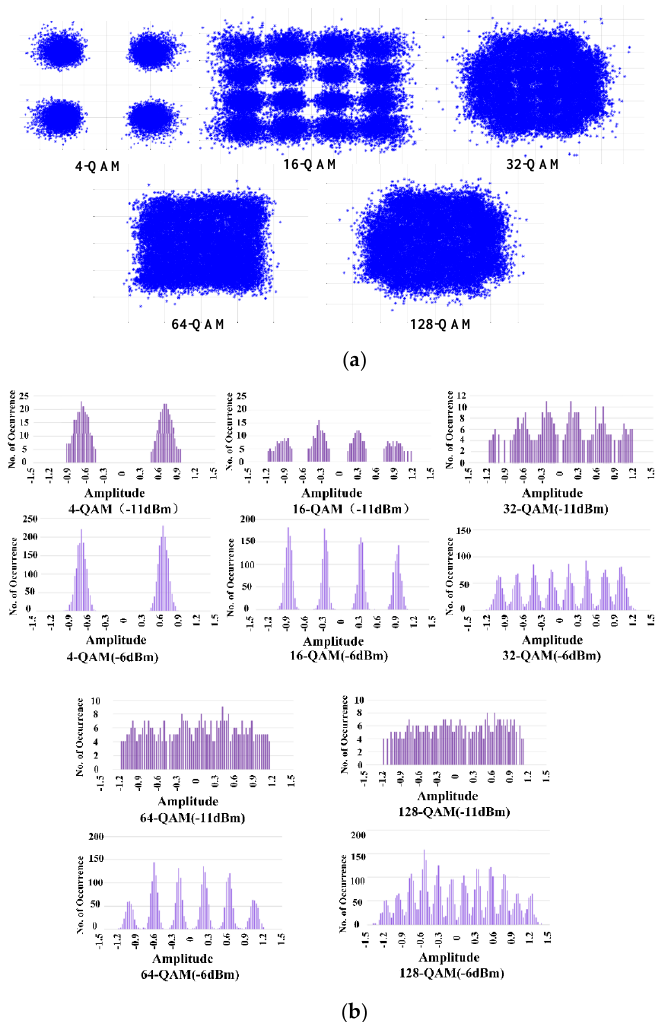
Figure 3. Subcarrier bit allocation profile for orthogonal frequency division multiplexing (OFDM) signals.